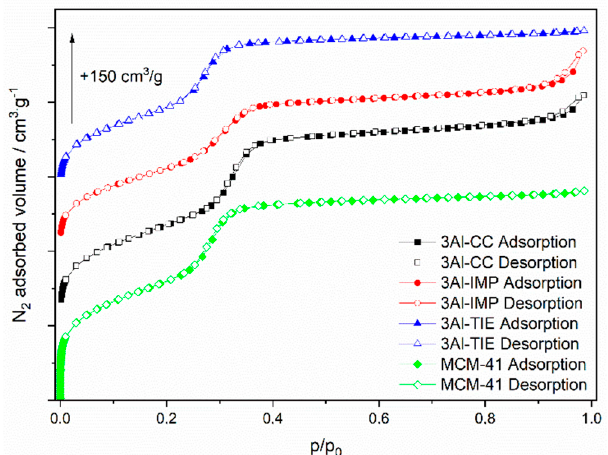
Figure 2. Nitrogen adsorption-desorption isotherms of MCM-41, modified with aluminum by different methods, and for pure silica MCM-41.